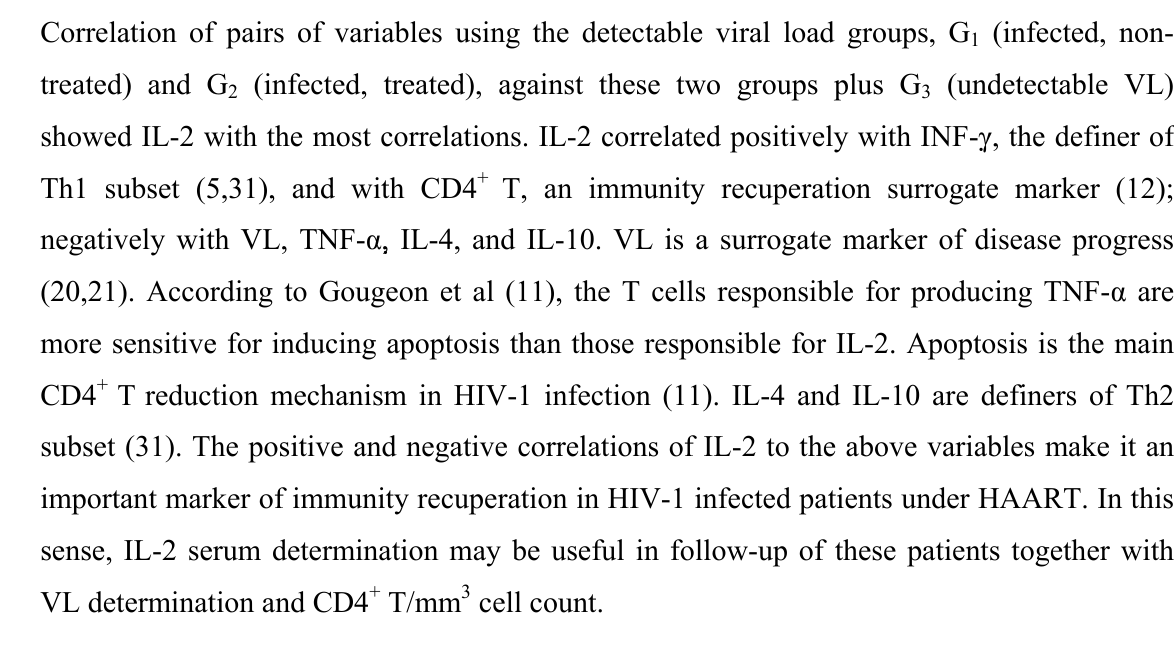
D. A. Meira et al . CORRELATION BETWEEN CYTOKINE SERUM LEVELS, NUMBER OF CD4 + T CELLS/mm³ AND VIRAL LOAD IN HIV-1 INFECTED INDIVIDUALS WITH OR WITHOUT ANTIRETROVIRAL THERAPY.